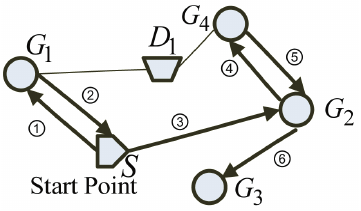
Fig. 4. A special situation.